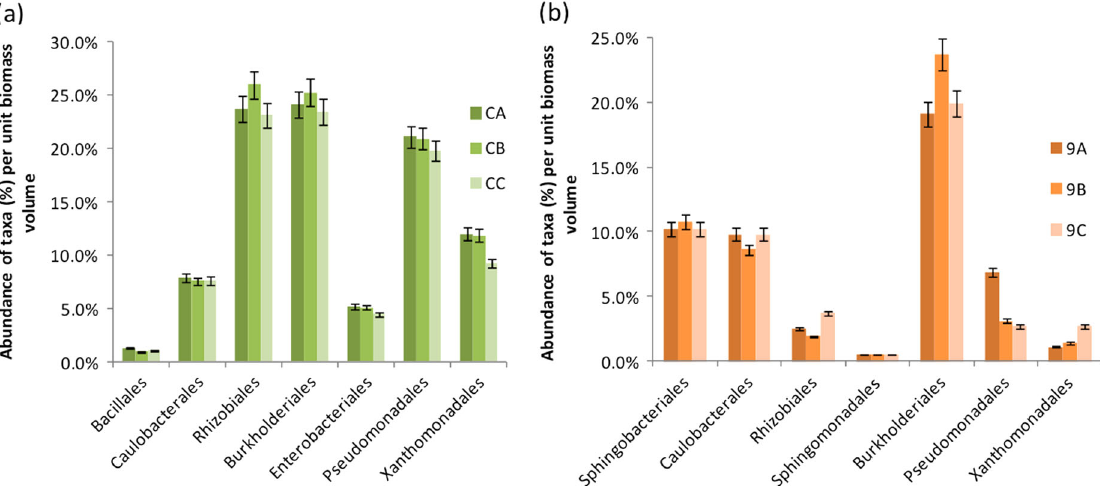
Fig. 4 Abundance of major taxonomic orders (%) per unit biomass volume of RO-membrane-bio fi lm in replicate samples of unused control membranes ( a ) and fouled membranes ( b ) Error bars represent percent